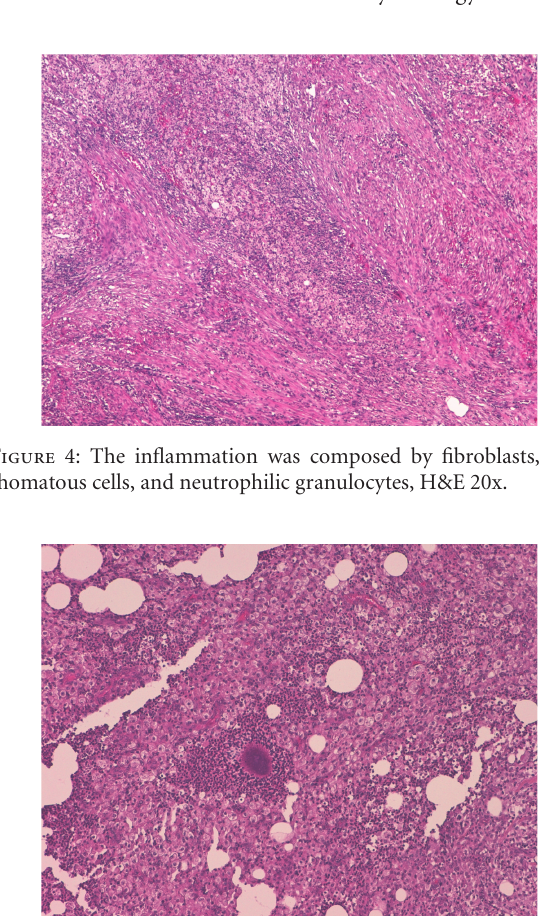
Figure 5: Colonies of Actinomyces species were detected with sur- rounding inflammatory infiltration, H&E 40x.